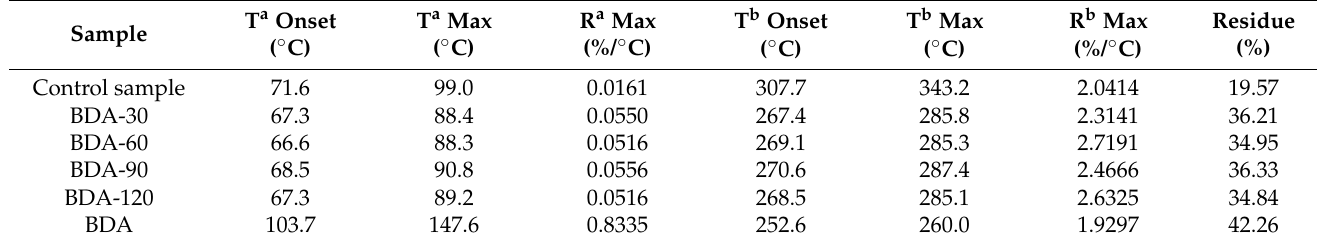
Table 4. TG analysis data of control sample and BDA treated samples (3 curing times, 50 LCs) under N 2.